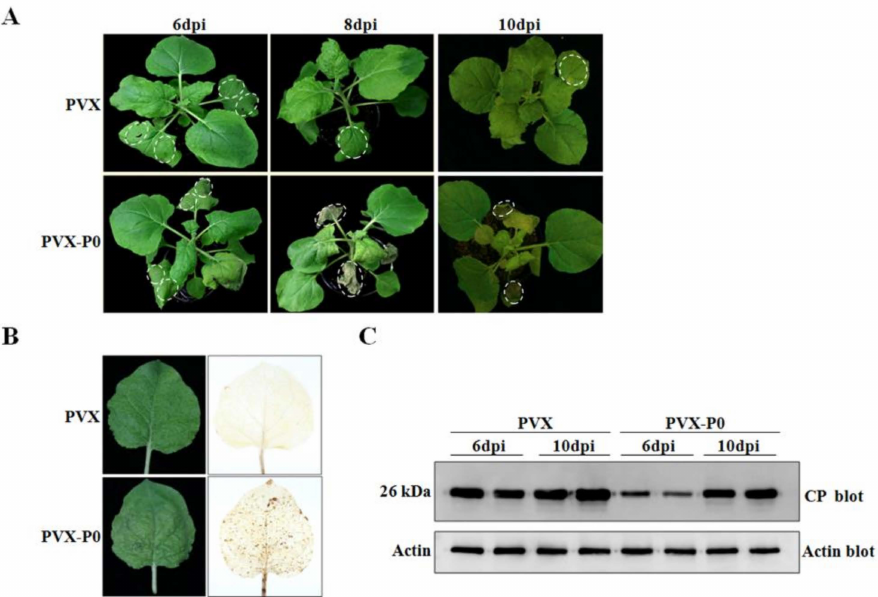
Figure 8. HR-like response induced by CVEV-DT1 P0 in a PVX expression assay. ( A ) Symptoms produced in N. benthamiana plants agroinfiltrated with PVX-based vector expressing CVEV P0 protein. ( B ) Detection of H 2 O 2 accumulation in N. benthamiana leaves by DAB absorption method at 8 dpi. ( C ) Detection of the expression of PVX CP by Western